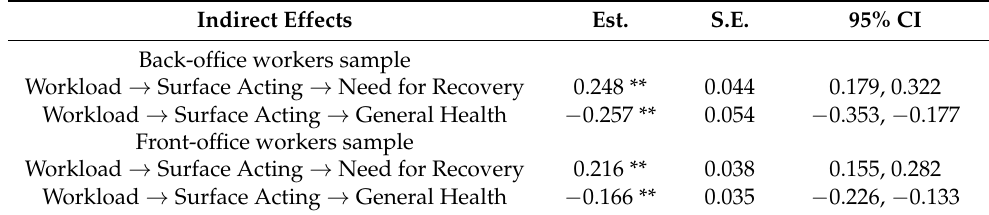
Table 3. Indirect effects using bootstrapping with 5000 replications (ML estimation; back-office sample N = 436; front-office sample N =